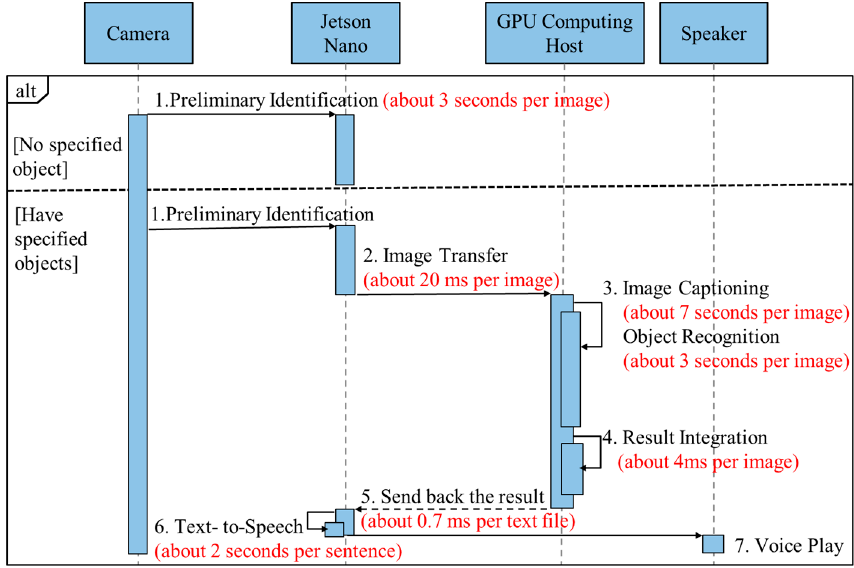
Figure 6. Process flow diagram of the proposed system.